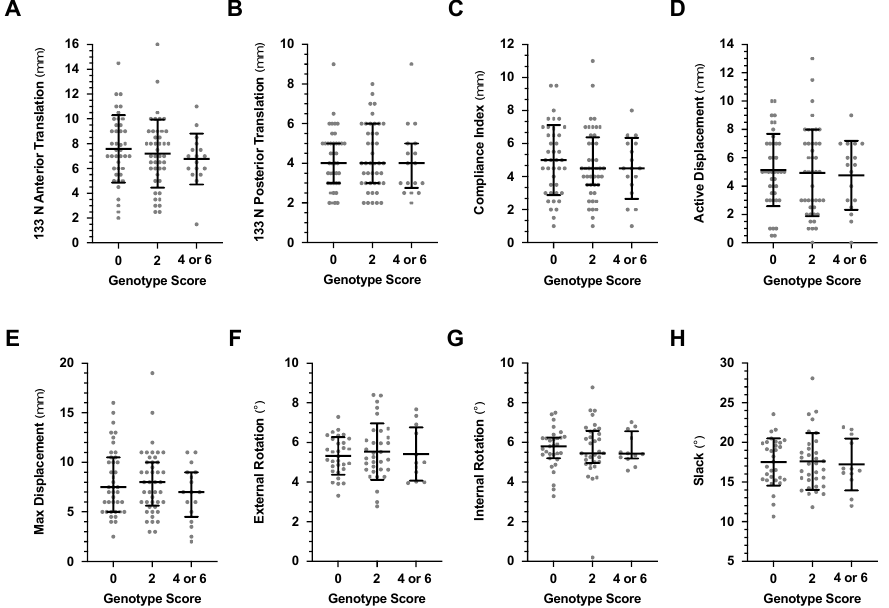
Figure 2. The mean ± standard deviation or median (IQRs) of the ( A – E ) five anterior-posterior laxity and ( F – H ) three external-internal rotation measurements of the protective α 1(V) ( COL5A1 ), α 1(XI) ( COL11A1 ) and α 2(XI) ( COLL12A1 ) collagen genotype scores. Participants received a genotype score of 2 for each COL5A1 rs12722 CC, COL11A1 rs3753841 CC, COL11A1 rs1676486 TT and COL12A1 rs1799907 AA genotypes and 0 for all other genotypes, so that the genotype scores ranged from 0 to 8. None of the participants had a genotype score of 8 and the genotype scores of 4 and 6 were combined for the analysis. The individual values are shown as solid grey circles.